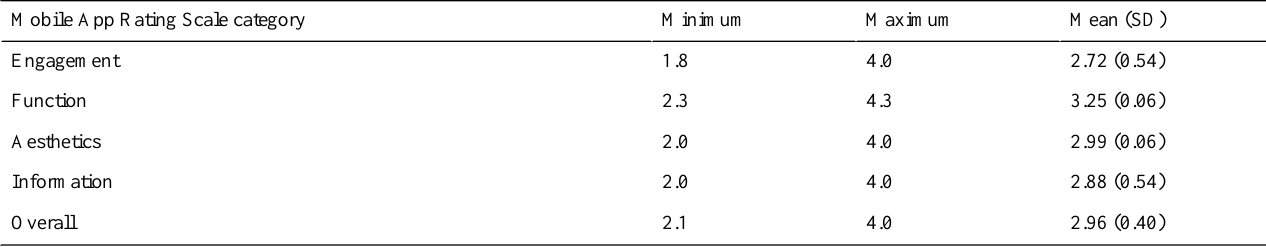
Table 1. Mean Mobile App Rating Scale scores of mental health apps (N=63).